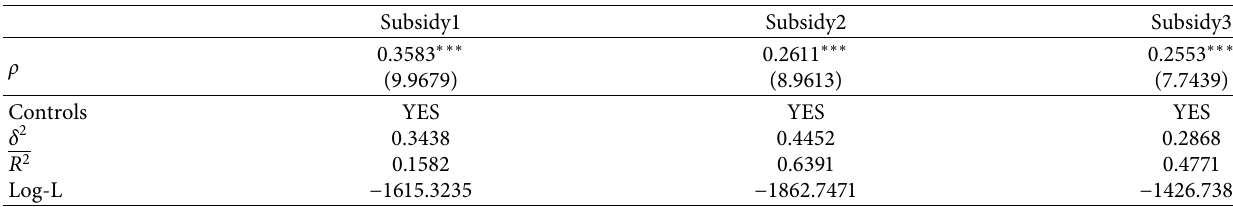
Table 9: Identification of spatial competition effects of subsidies.